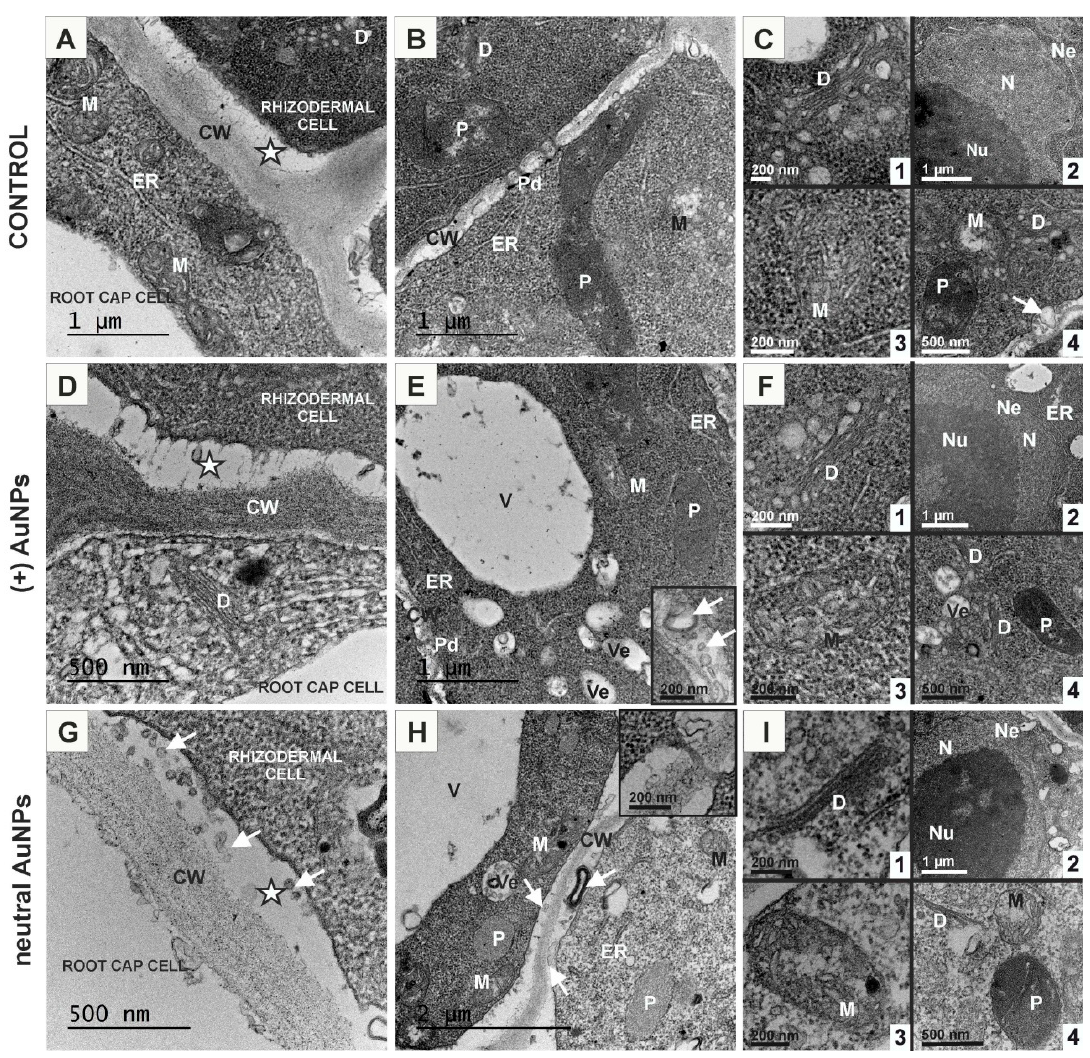
Figure 2. Ultrastructure of rhizodermal cells from the control roots ( A–C ); treated with (+) AuNPs ( D–F ) and neutral AuNPs ( G–I ). CW—cell wall, D—dictyosome, ER—endoplasmic reticulum, M—mitochondria, N—nucleus; Ne—nuclear envelope; Nu—nucleolus; P—plastid; Pd—plasmodesmata; V—vacuole; Ve—vesicle; arrows—paramural bodies; asterisks—periplasmic spaces.